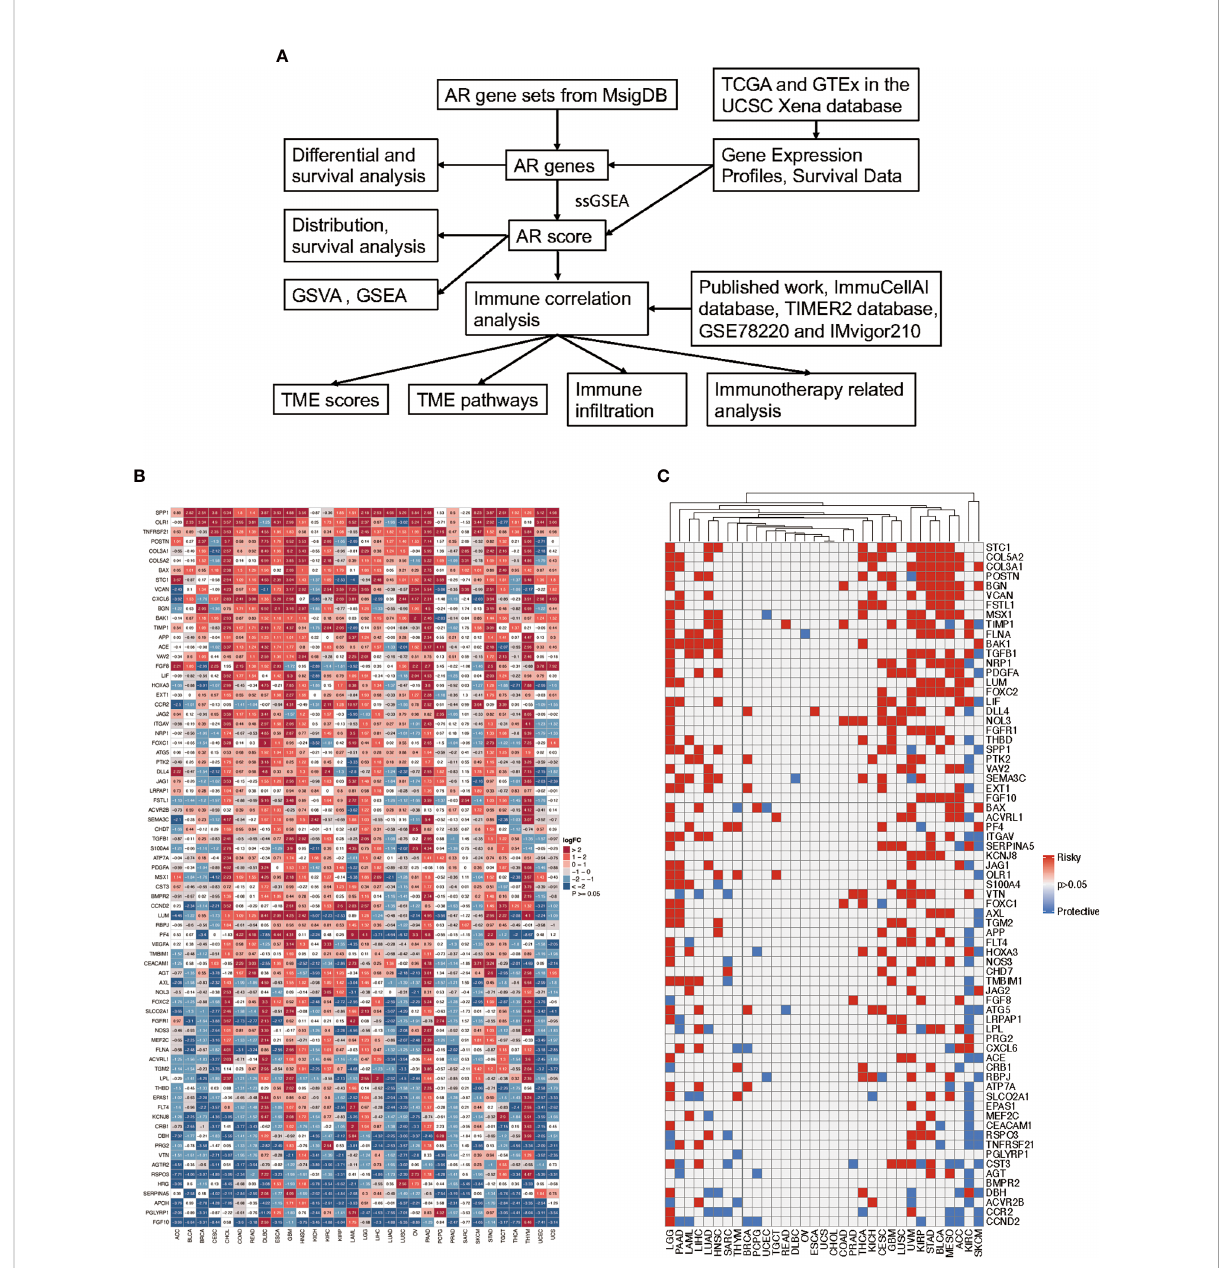
FIGURE 1 Flow chart of the study and the expression and prognosis of angiogenesis and remodeling (AR) genes. (A) Schematic diagram illustrating the research design of this study. (B) The heatmap exhibiting the transcriptional level of AR genes in 31 tumor types compared to adjacent normal tissues based on TCGA and GTEx database; the gradient colors represent the log fold change (logFC) value (Red points indicate high expression, while blue points indicate low expression). (C) Overall survival analysis of AR genes in 33 tumors of TCGA was analyzed by univariate Cox regression; the gradient colors represent the hazard ratios (Red points indicate high-risk prognostic factor, while blue points indicate protective